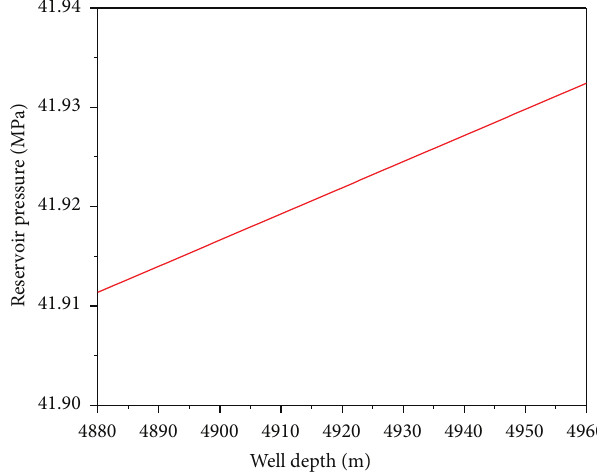
Figure 13: Reservoir pore pressure profile estimated using the improved methodology.